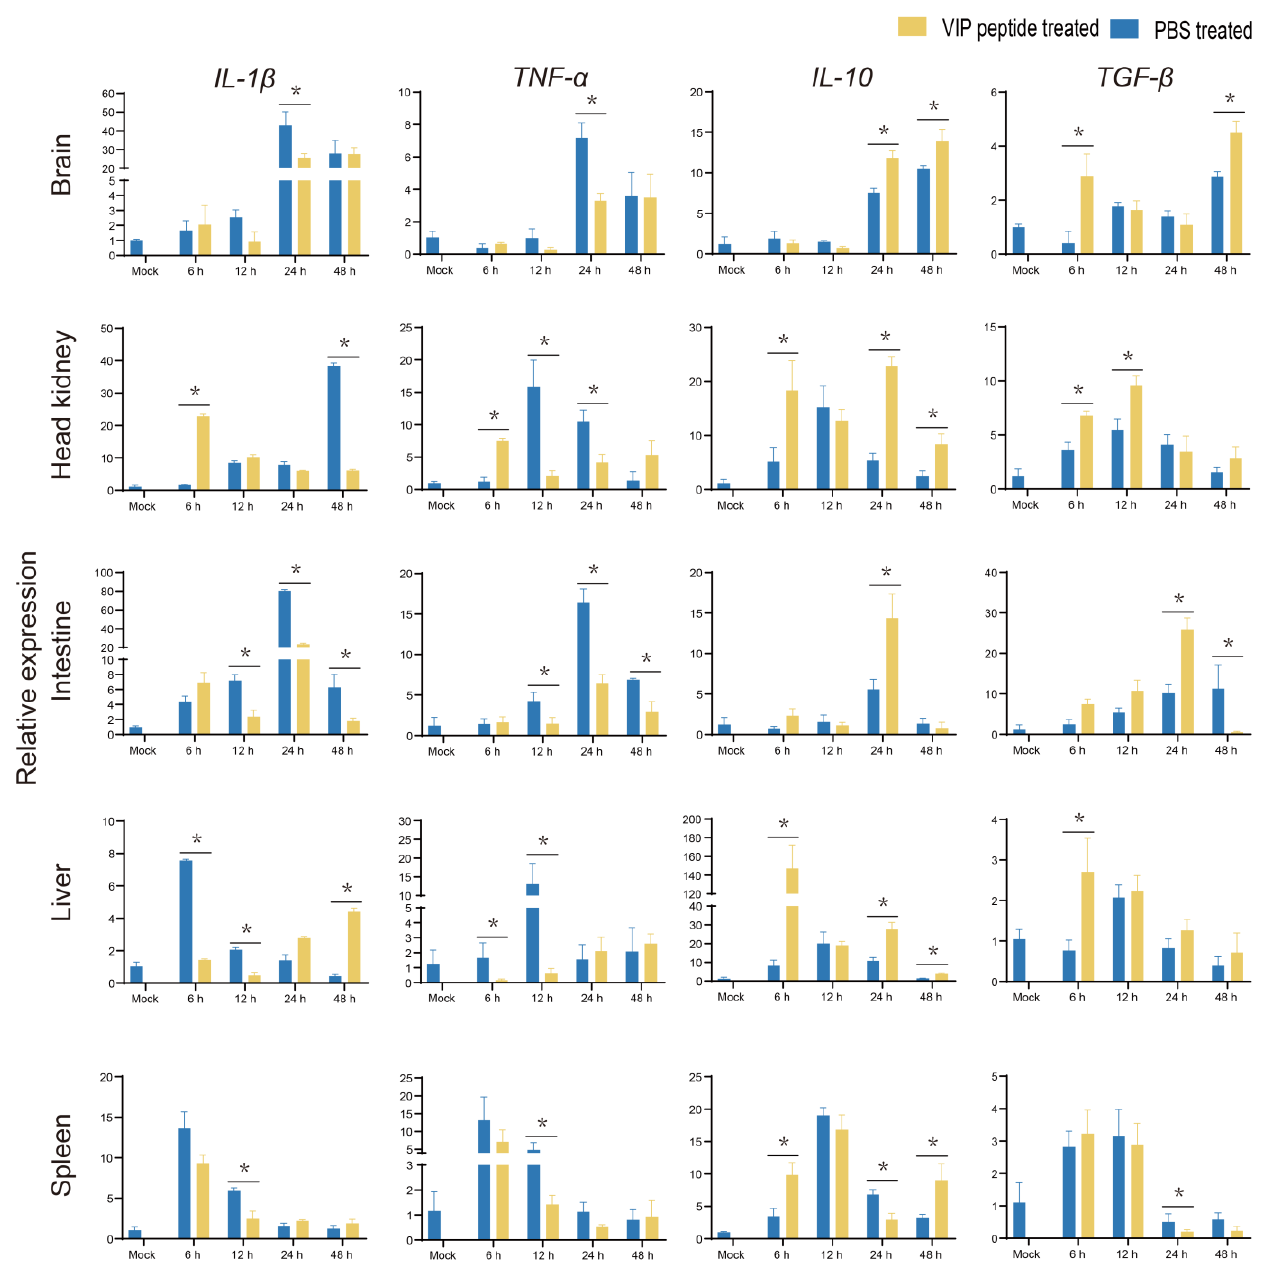
Figure 8. The expression patterns of inflammatory-related factors ( IL-1β , TNF-α , IL-10 , and TGF-β ) at various points after S. agalactiae infection via qRT-PCR. Every value was presented as the mean and standard deviation; n = 3. The asterisks reveal the significant difference ( p < 0.05).